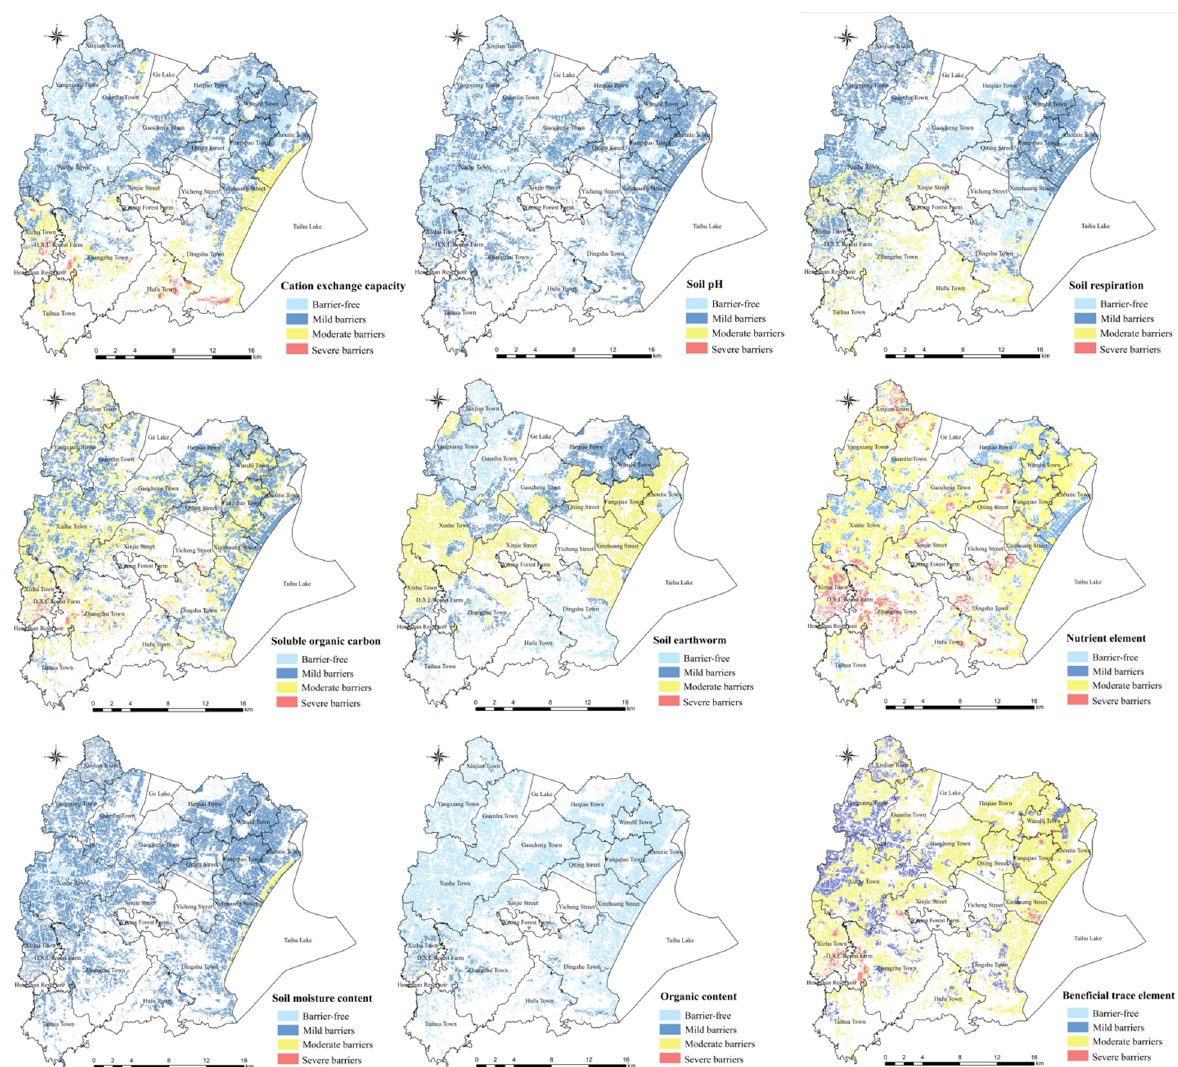
Figure 6. Spatial distribution of obstacle degree of some SH evaluation indicators in Yixing City.